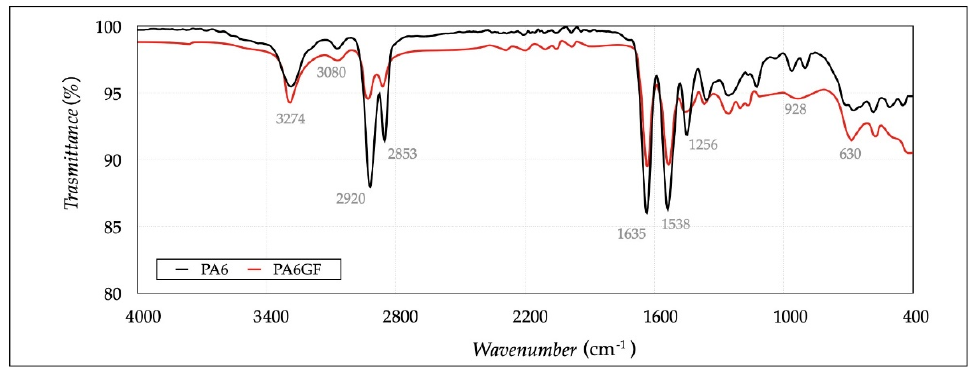
Figure 5. FT-IR spectra of the two materials.